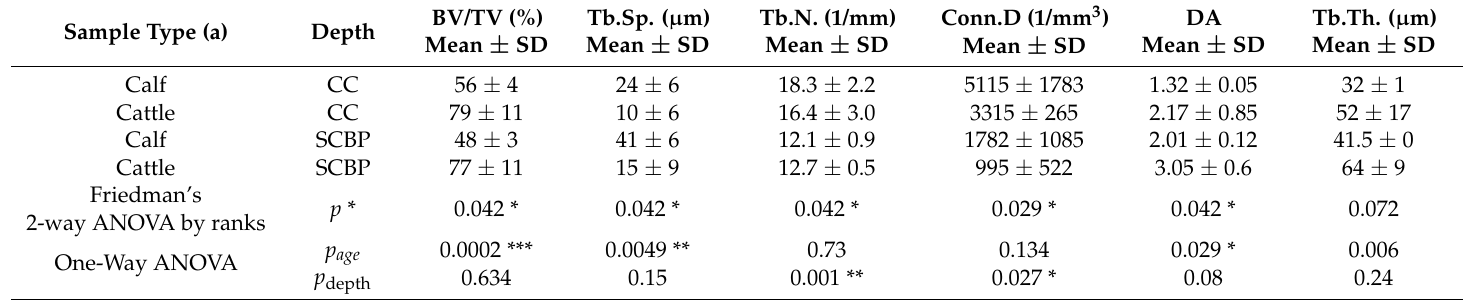
Table 2. Quantitative micro-CT analysis of the individual layers of the subchondral bone; One-way ANOVA was performed to evaluate the effect of age ( p age ), as well the distance from tidemark ( p depth ) on bone indices (* p < 0.05, ** p < 0.01, *** p < 0.001). Mean ± standard deviations (SD) are